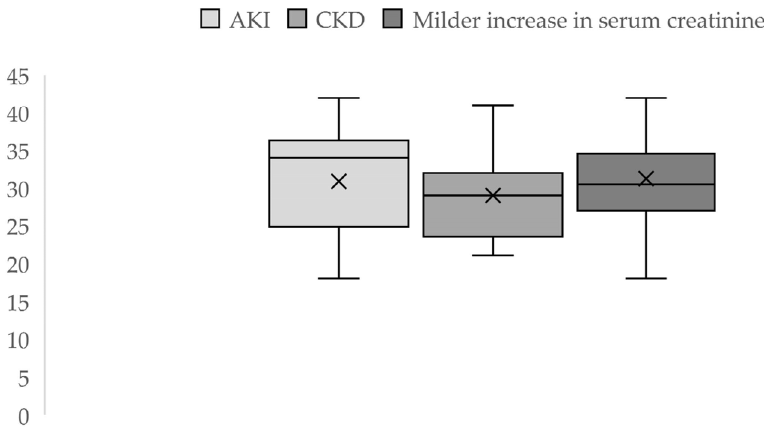
Figure 2. Descriptive statistics of maternal age by groups.